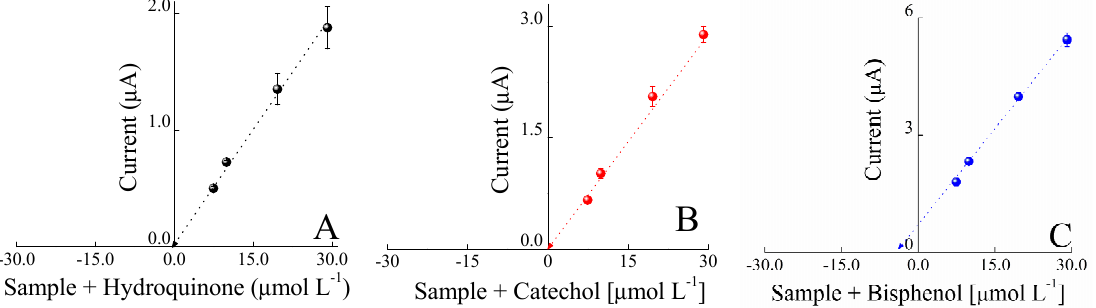
Figure 7. Calibration plots using standard addition to analyze water samples. ( A ) hydroquinone, ( B ) catechol and ( C ) BPA. Conditions: phosphate buffer solution 0.1 mol L − 1 , pH 7.0.